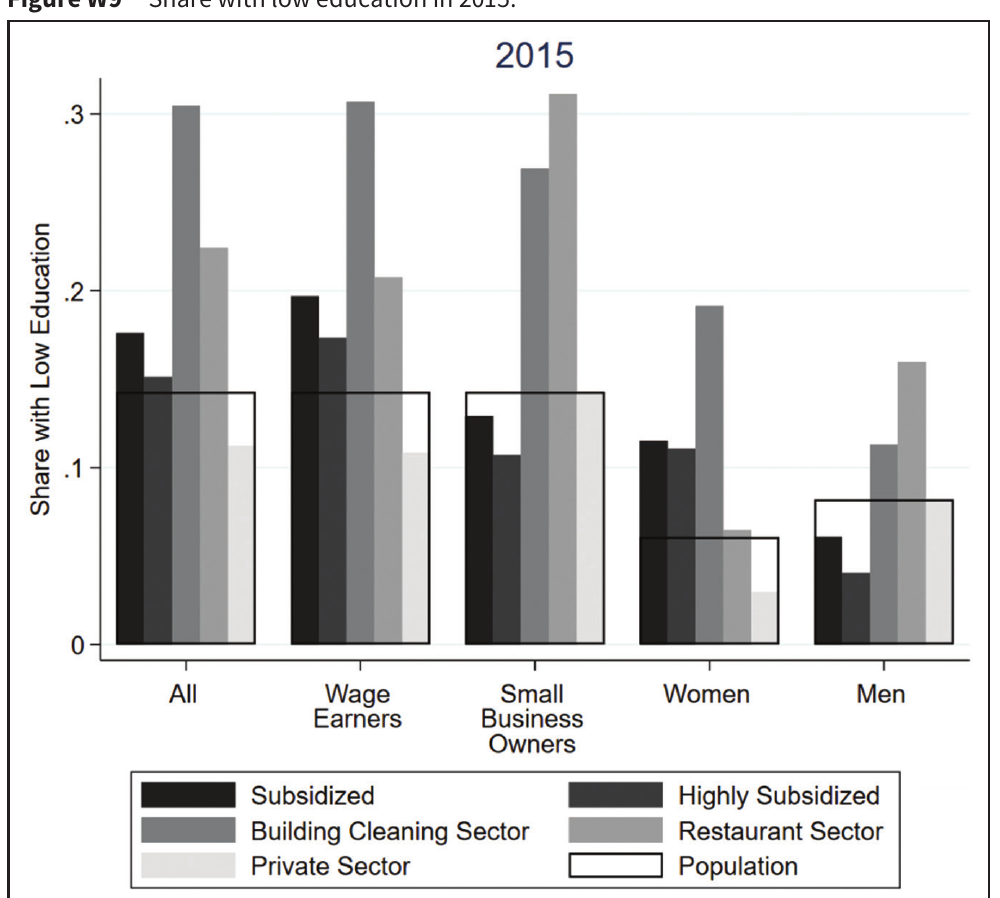
Figure W9 Share with low education in 2015.